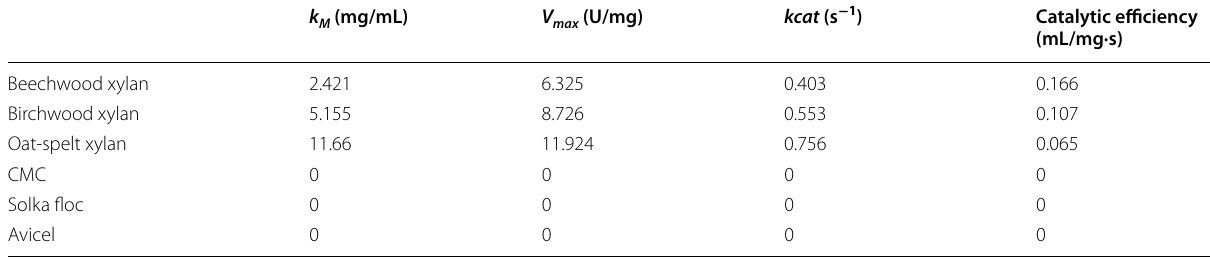
Table 3 Kinetic properties of Lr